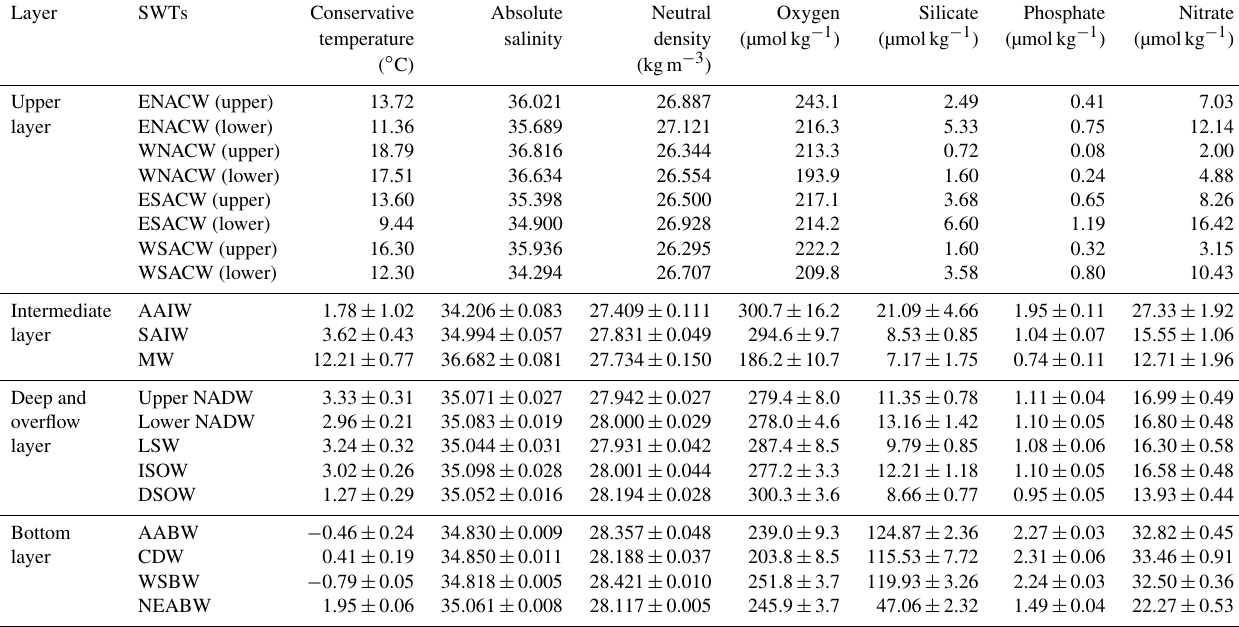
Table 4. Table of the mean value and the standard deviation of all variables for all the water masses (i.e. source water types) in this study. Layer SWTs Conservative Absolute Neutral Oxygen Silicate Phosphate Nitrate temperature salinity density Upper ENACW (upper)